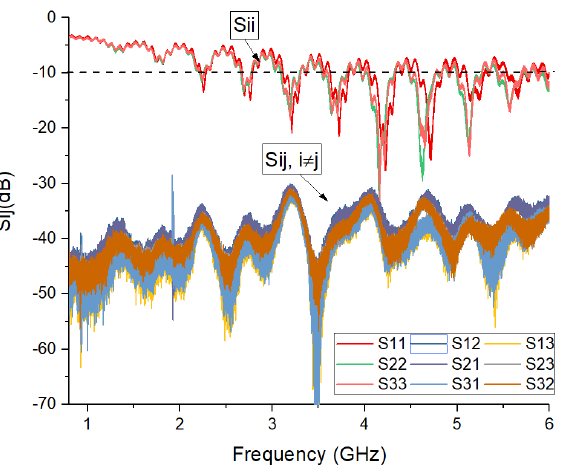
Figure 8. Variation with frequency of the reflection and transmission coefficients of the sensor elements when the mutual coupling is present. The reflection coefficients (Sii) are higher at lower frequencies and the resonant